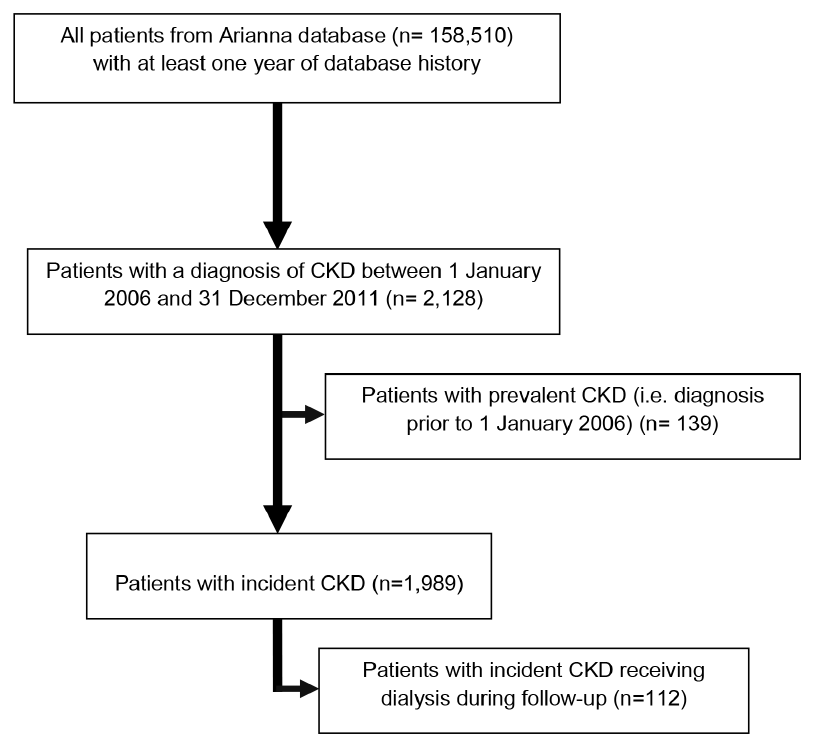
Figure 1. Flow chart of CKD patients included in the study.